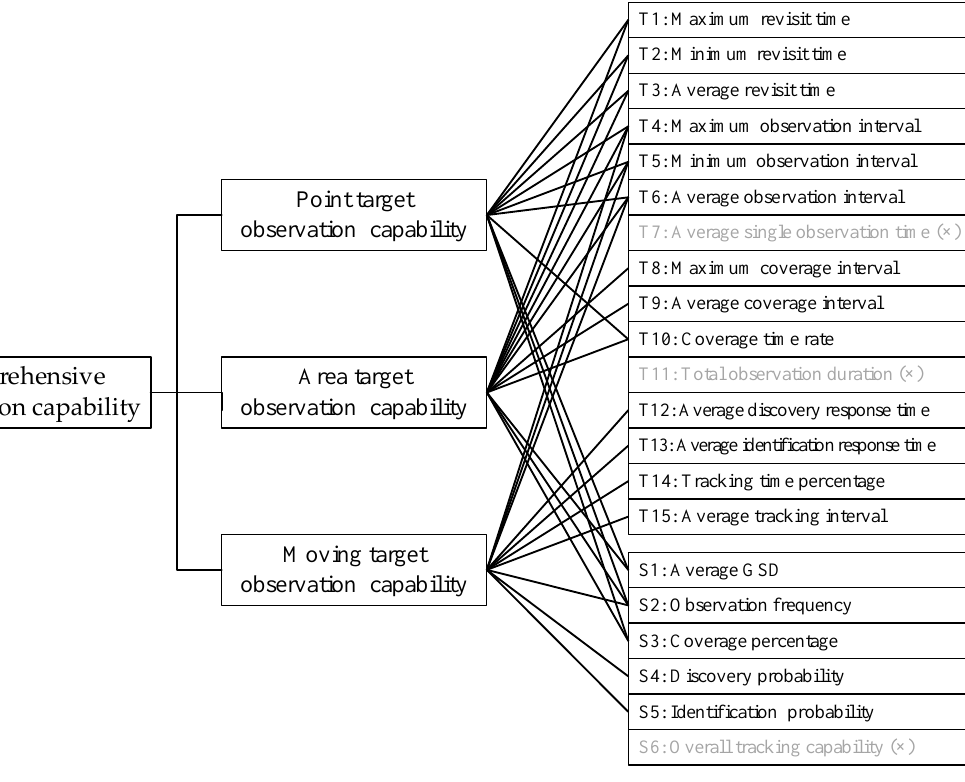
Figure 5. Preliminary screening result of the index system.